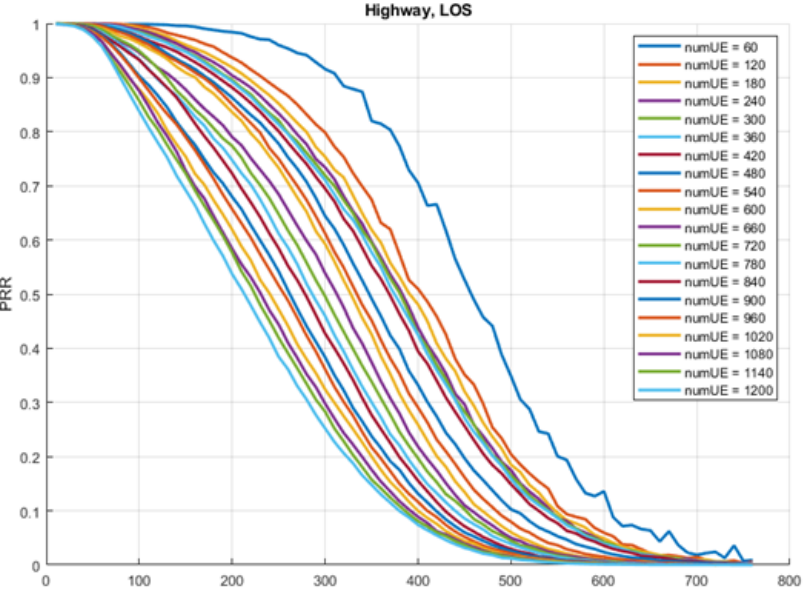
Figure 1. PRR of C-V2X communication data generated using a proprietary simulation